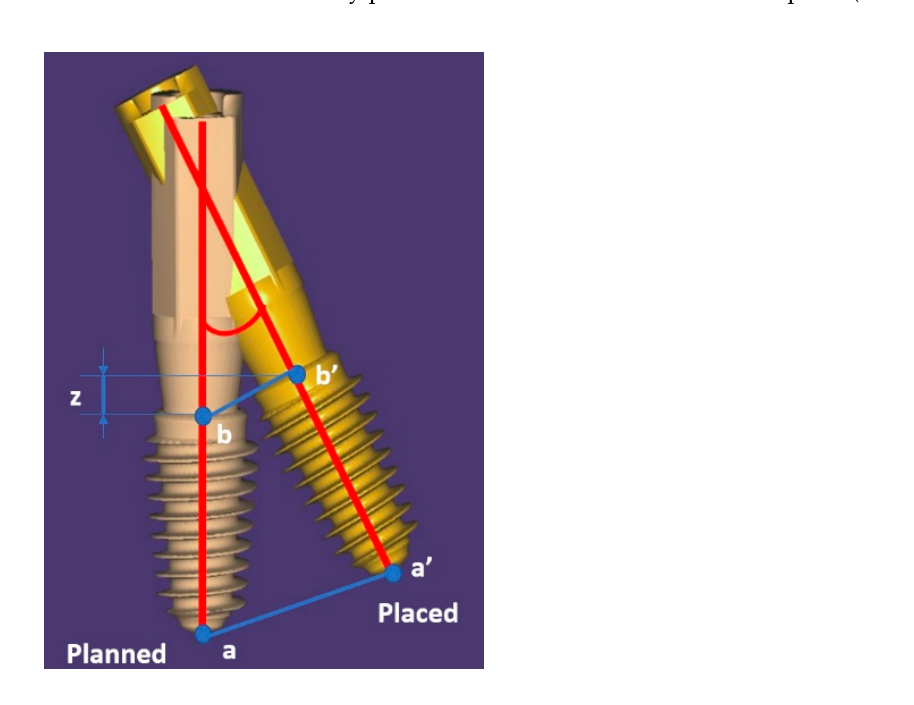
Figure 5. Precision assessment: S1 (digital scan at implant insertion) was compared with S2 (digital scan for final prosthetic manufacturing) in Geomagic Control X software. ( A ) 3D measurements at marginal border; ( B ) Angular deviation meas- urement.